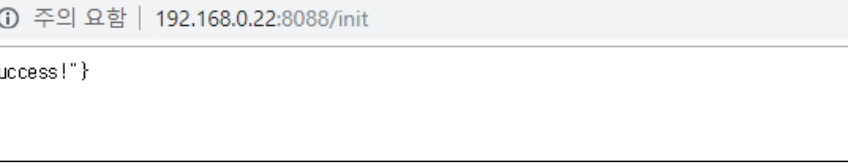
Figure 9. Result of initializing the Kong API gateway using the init API.